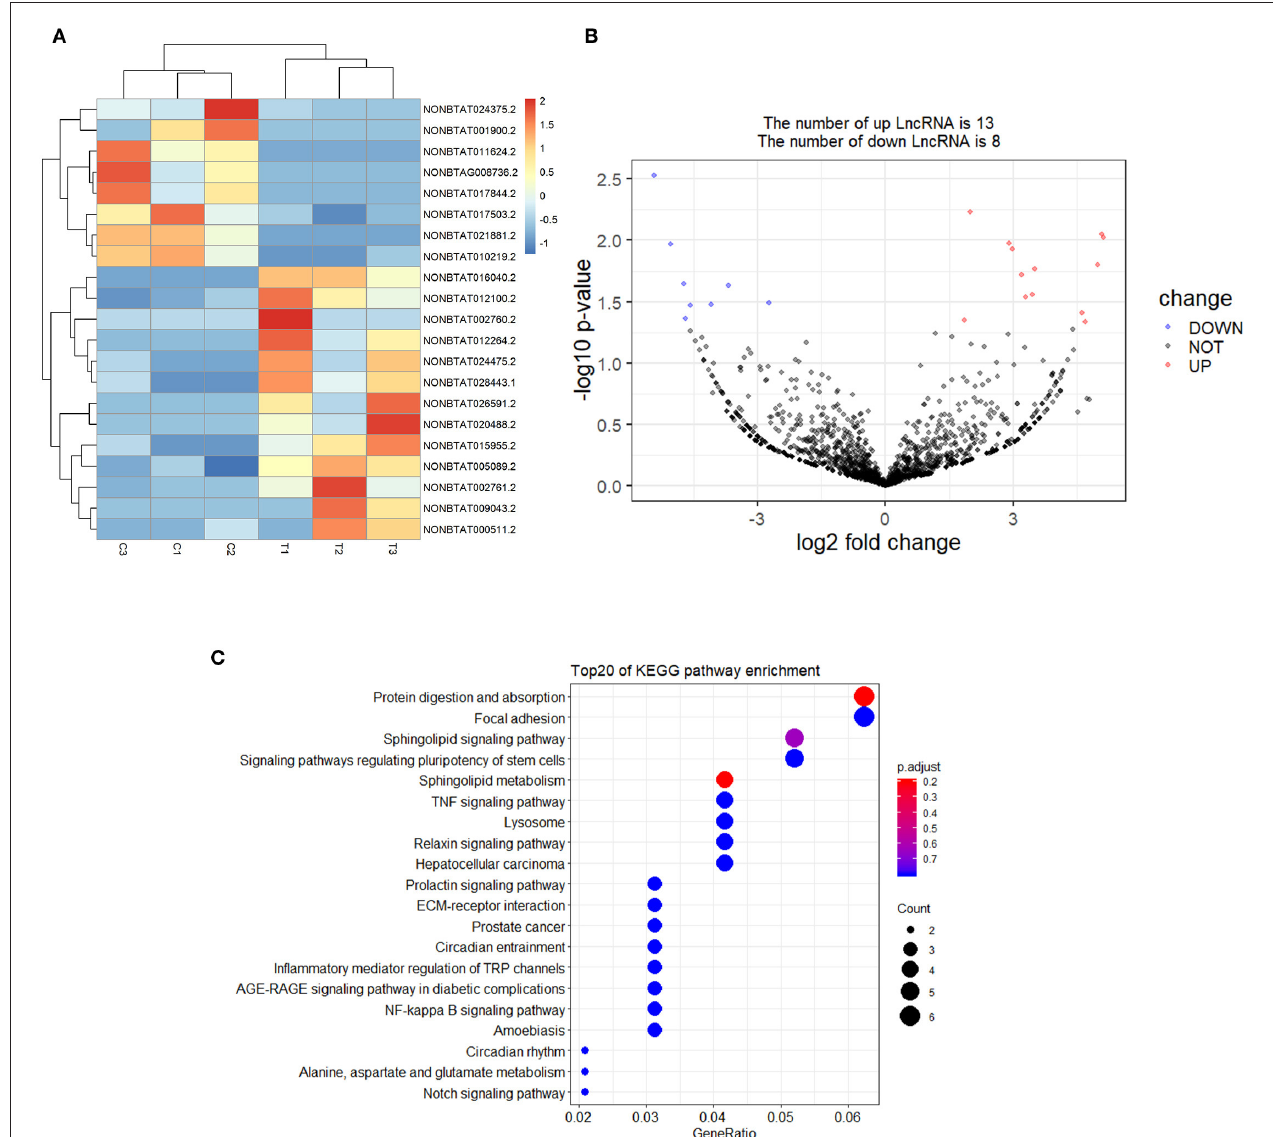
FIGURE 4 | Screening and enrichment analysis of differently expressed lncRNAs (DElncRNAs) in S. aureus infected mammary epithelial cells compared with non-infected mammary epithelial cells. (A) Cluster analysis of DElncRNAs in mammary epithelial cells between the control group and treatment group. (B) Volcano plot of global DElncRNAs in mammary epithelial cells between control group and treatment group. (C) KEGG pathway classification for the annotation of DElncRNAs in mammary epithelial